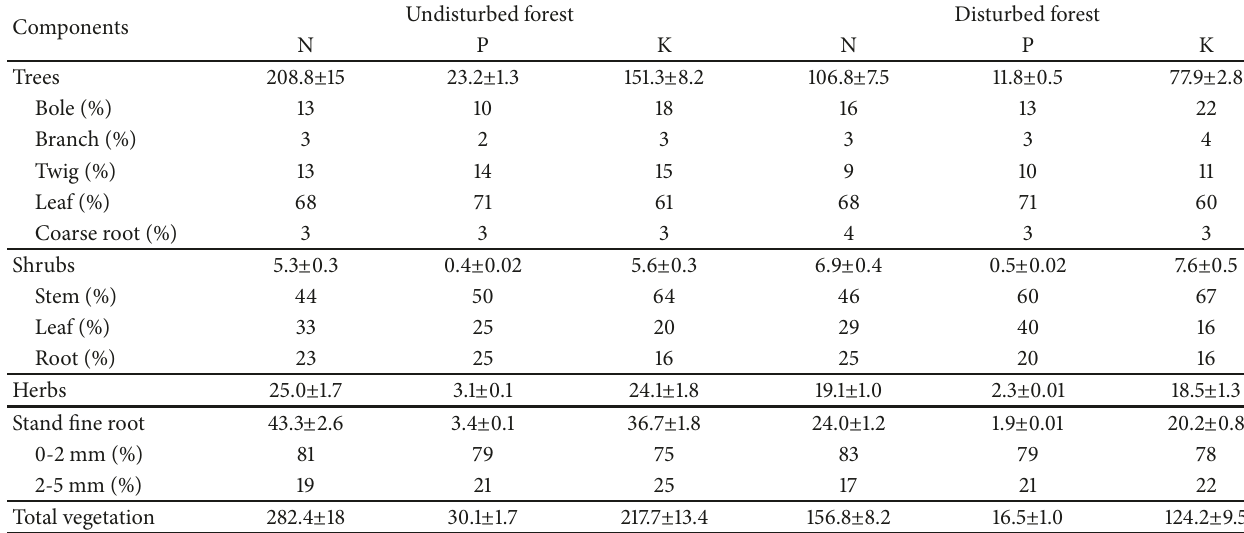
Table 4: Gross uptake of nutrients (kg ha – 1 y – 1 ) in tree, shrub, herb, and fine root in undisturbed and disturbed forest stands of moist tropical forest of Sunsari district, eastern Nepal (mean ±